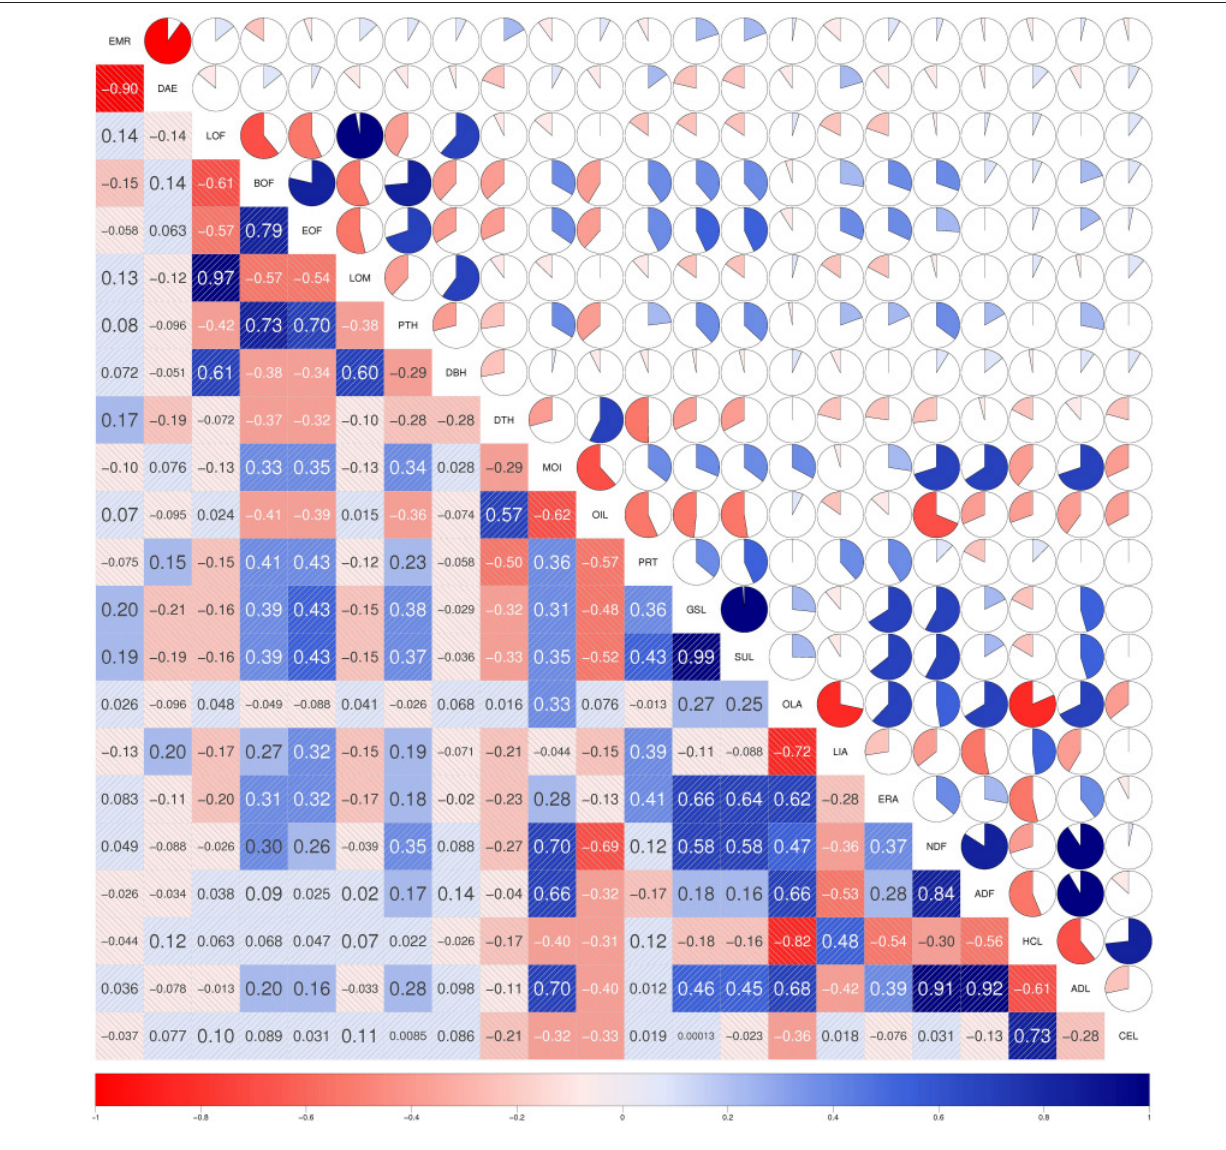
FIGURE 6 | Correlations of the agronomic and seed quality traits across the 188 inbreds of the spring trial. In the diagonal panel the traits are listed. In the upper panel the filled portion of the pie and in the lower panel the depth of the shading as well as the font size indicate the magnitude of the correlations. Negative correlations are colored red and positive correlations